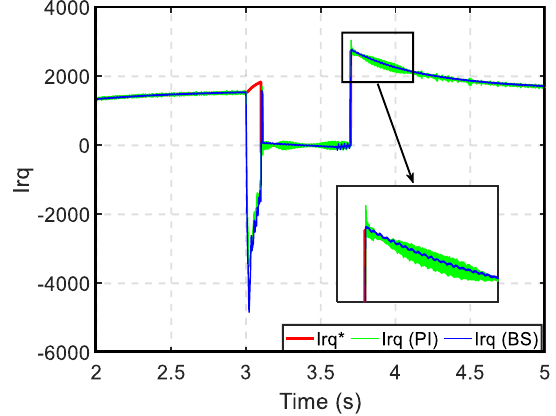
Fig. 18 Evolution of the q component of the flux